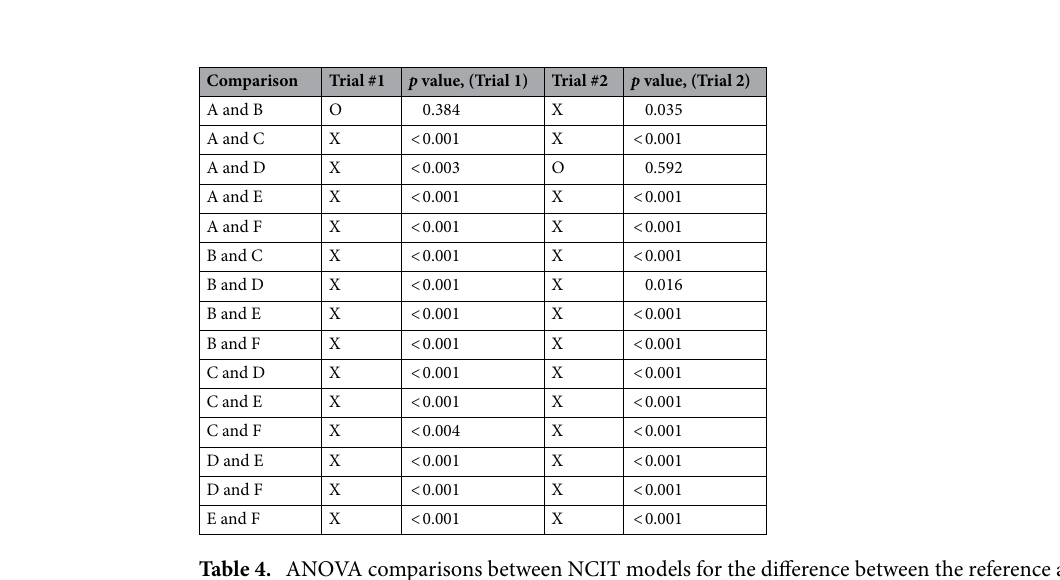
Table 3. Number of measurements outside of the manufacturer’s accuracy claim.